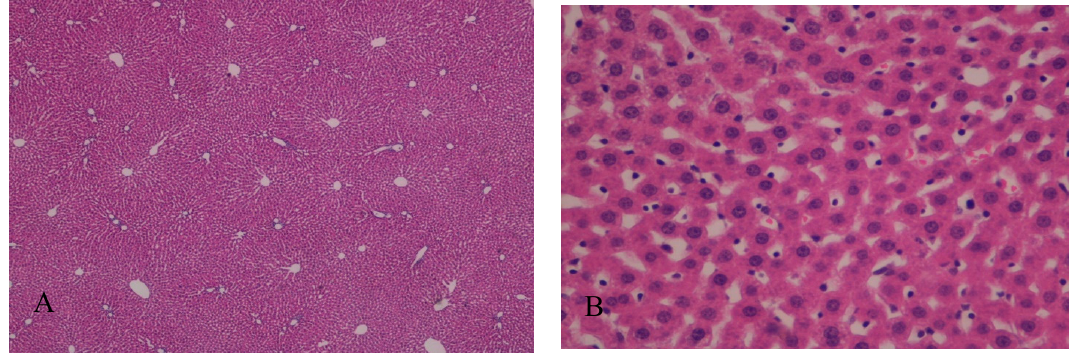
Figure 3. ( A ) The addition of berberine (BBR) in the liver preservation solution preserved the normal liver architecture after I/R injury; H&E, 40×. ( B ) Hepatocytes preserved the nucleus and intracellular organelles. The liver sinusoids present mild pericentrolobular dilation; H&E, 400×.